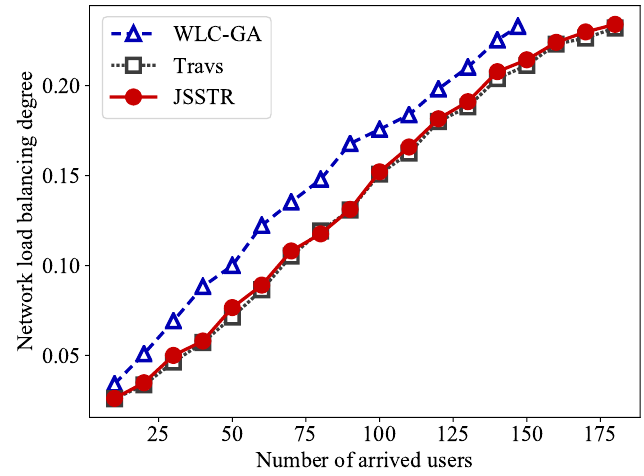
Figure 7. Network load balancing degree comparison for JSSTR, Travs and